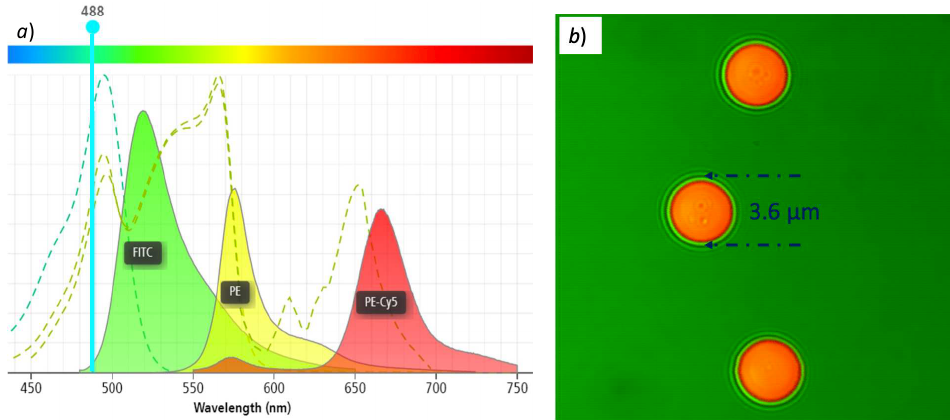
Figure 10. ( a ) Absorption and emission spectra of FITC, PE, and PE-Cy5 fluorophores under 488nm excitation; ( b ) ample calibration microbeads for flow-cytometry.